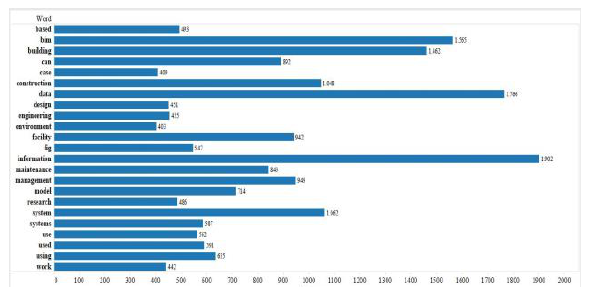
Figure 4: The word cloud of most frequent